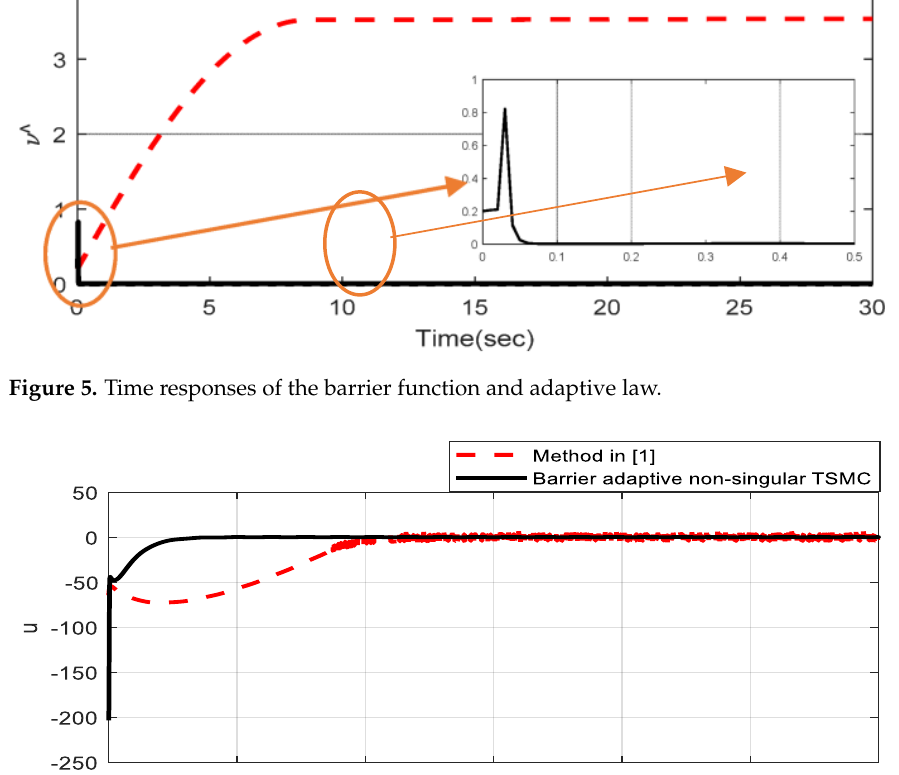
Figure 6. Trajectory of the control inputs.